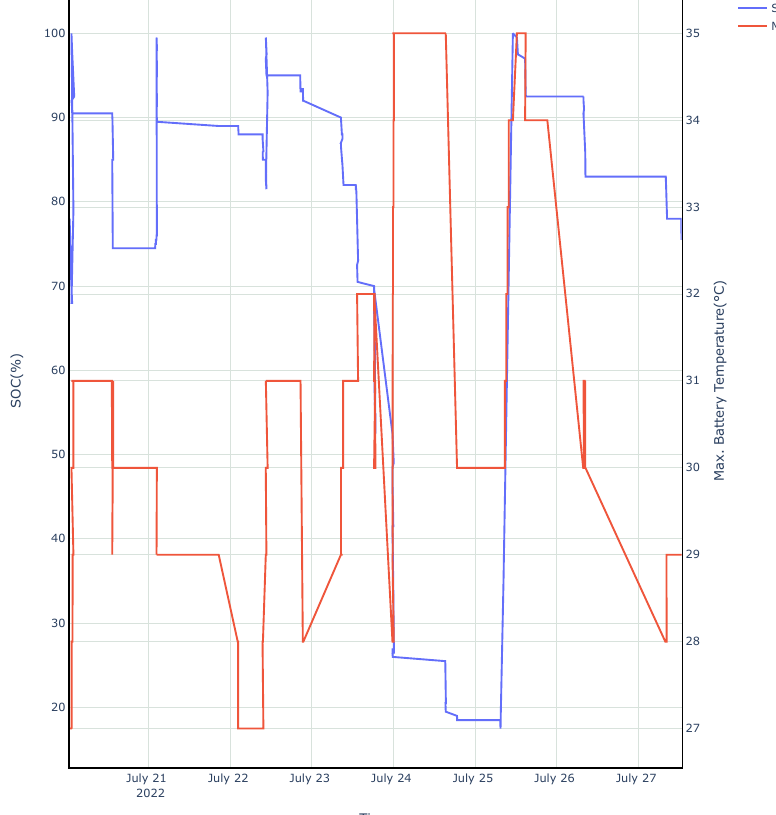
Figure 14. Graph of SOC effect on maximum battery temperature during vehicle